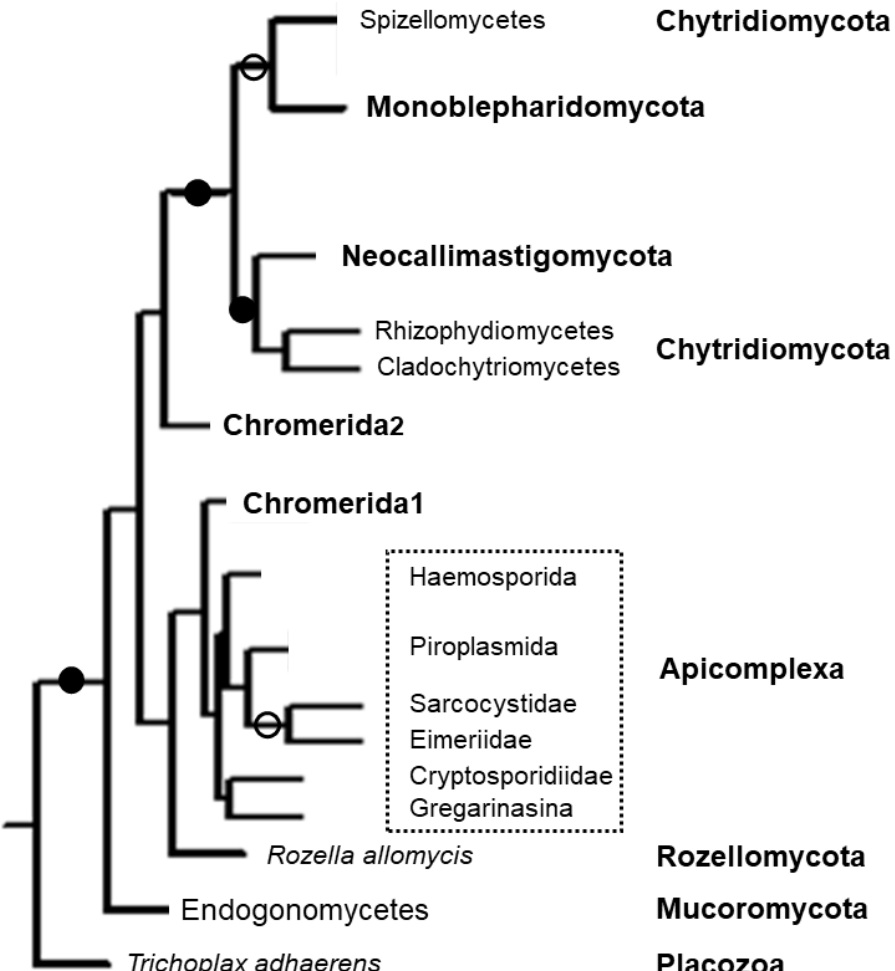
Figure 3. Phylogenetic tree of apicortins constructed by Maximum Parsimony (MP) analysis. Full and open circles at a node indicate that the branch was supported by MP bootstrap ≥ 85% and ≥ 50%, respectively. Bold, normal and italic letters indicate phyla, classes/orders/families and species, respectively. Phylogenetic units within the box belong to Apicomplexa. The figure based on Figure 3 of [8].